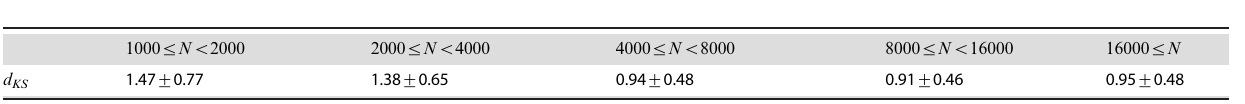
Table 3. Mean and standard-deviation over all pairs of countries of the KS distance d KS between the aggregated Q N ( v ) distributions in each country, for different values of N